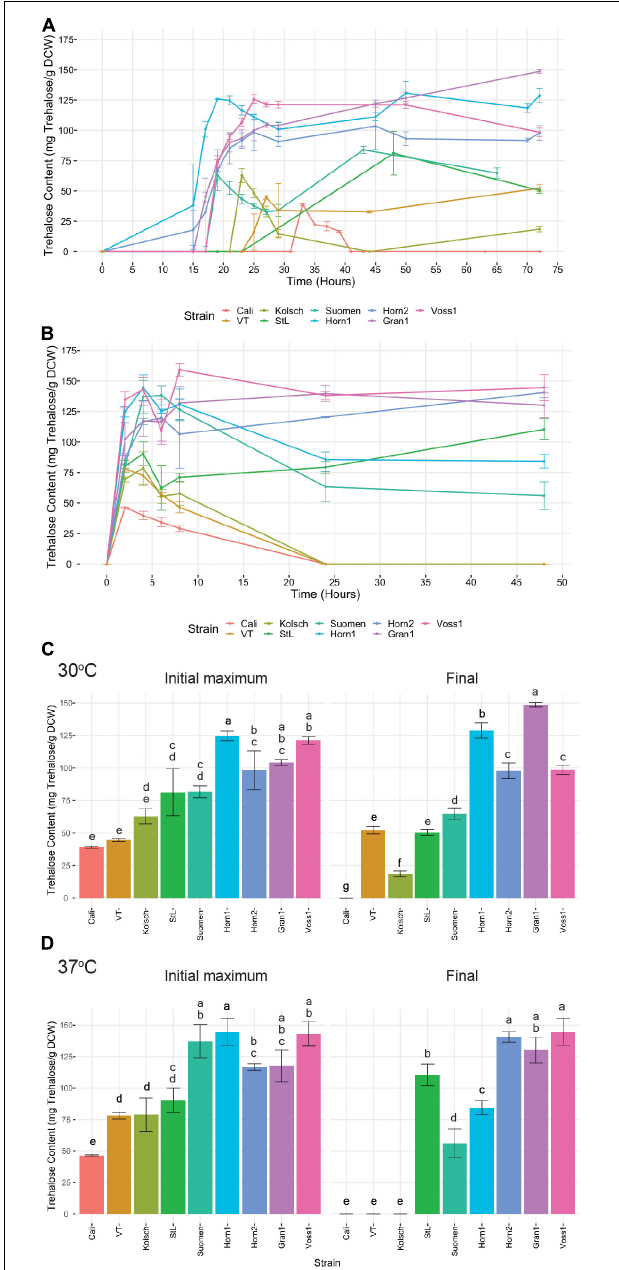
FIGURE 9 | Analysis of trehalose accumulation during growth in YPD at (A) 30 ◦ C and (B) 37 ◦ C. Single colonies were inoculated into 100 mL of YPD and incubated at 30 or 37 ◦ C with shaking at 170 rpm for 72 and 48 h, respectively. Cell samples were collected at the indicated times and trehalose extractions were performed and concentrations determined via HPLC (see “Materials and Methods”). Data points represent the mean of biological replicates ( n = 3), and error bars represent the standard deviation. The initial maximum trehalose accumulation and final trehalose concentrations were plotted (C) for the 30 ◦ C and (D) for the 37 ◦ C growths. Data was subjected to one-way ANOVA followed by Tukey’s HSD analysis of the mean trehalose content between strains for each timepoint and temperature (Trehalose Content ∼ Strain). Mean values assigned with a common letter are not significantly different by the HSD-test at the 5% level of